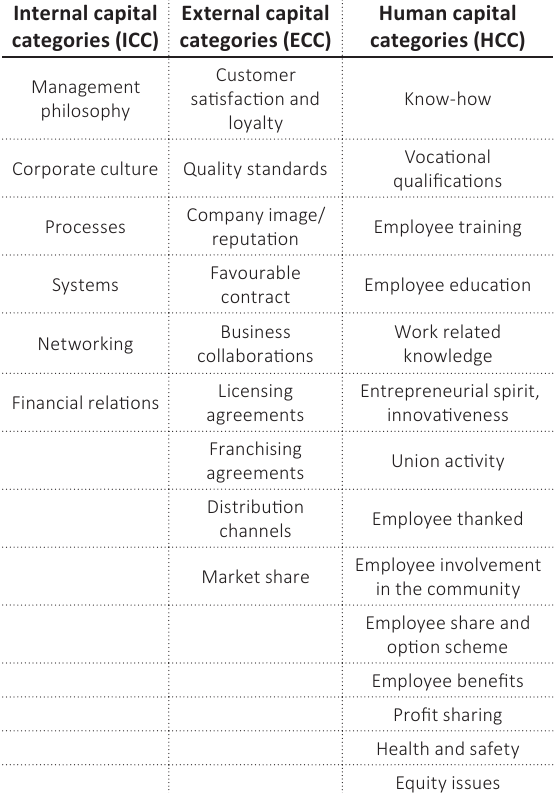
Table 1. Sample firms by industry